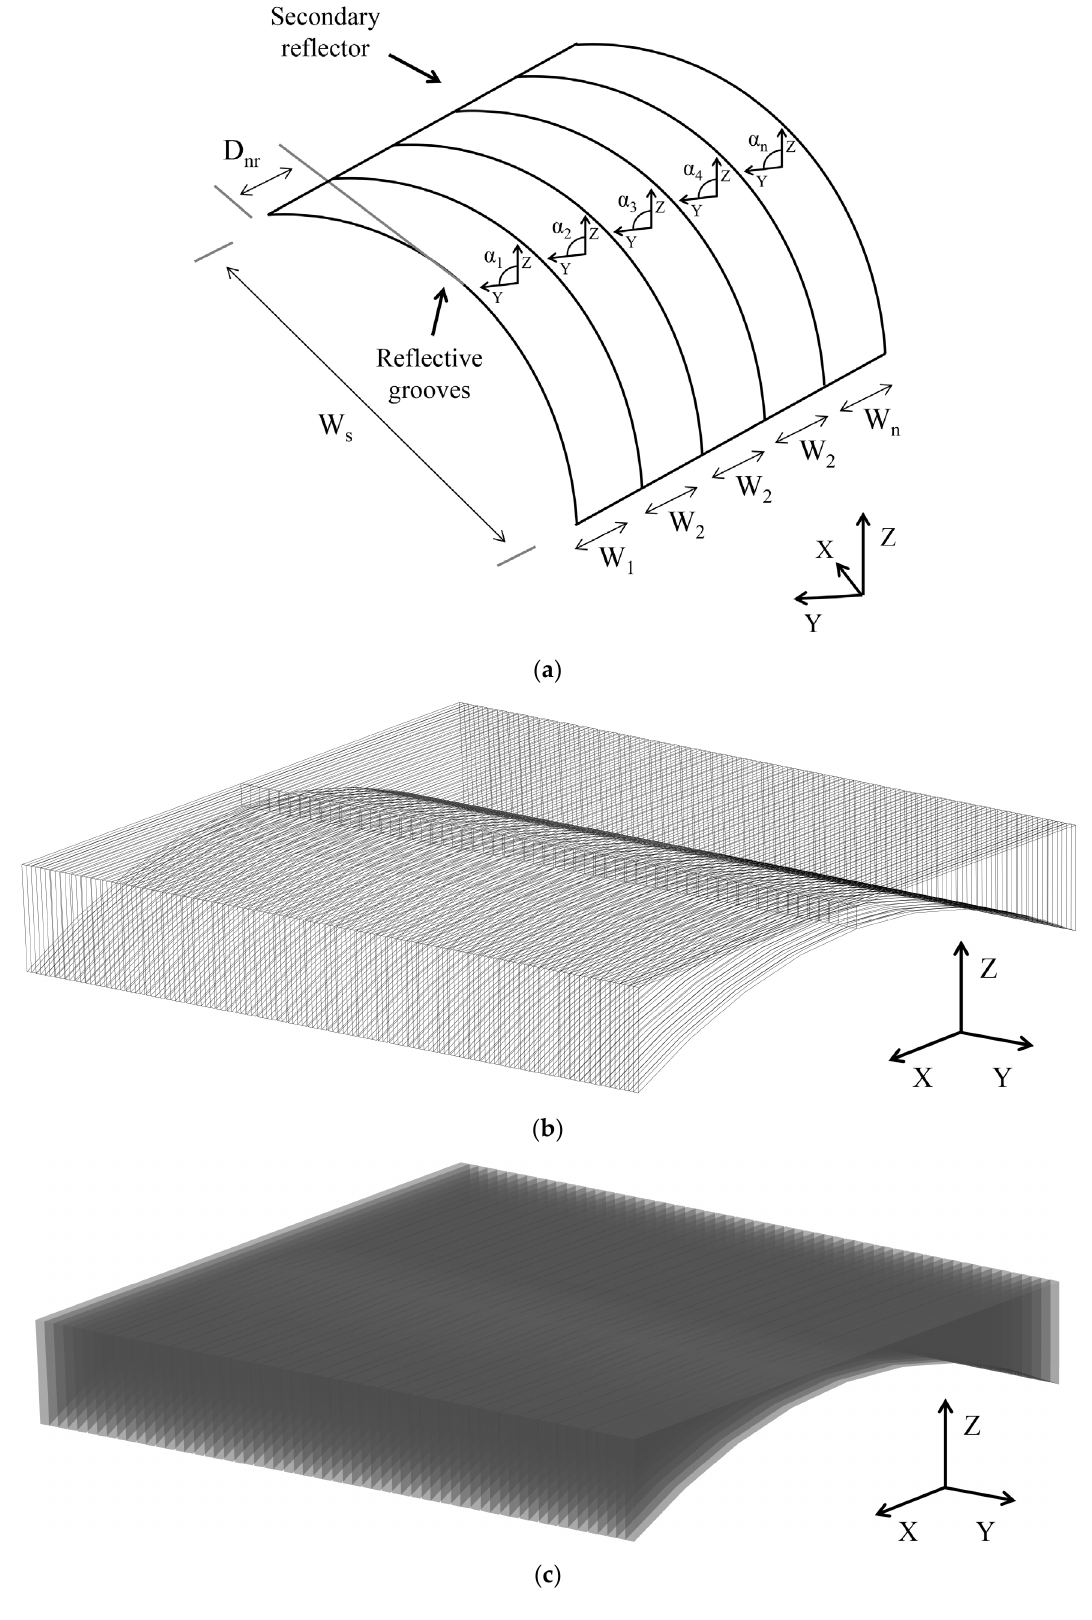
Figure 5. ( a ) Illustrating geometry of the reflective grooves, ( b ) 3D wireframe view, and ( c ) translucent view of the secondary reflector.